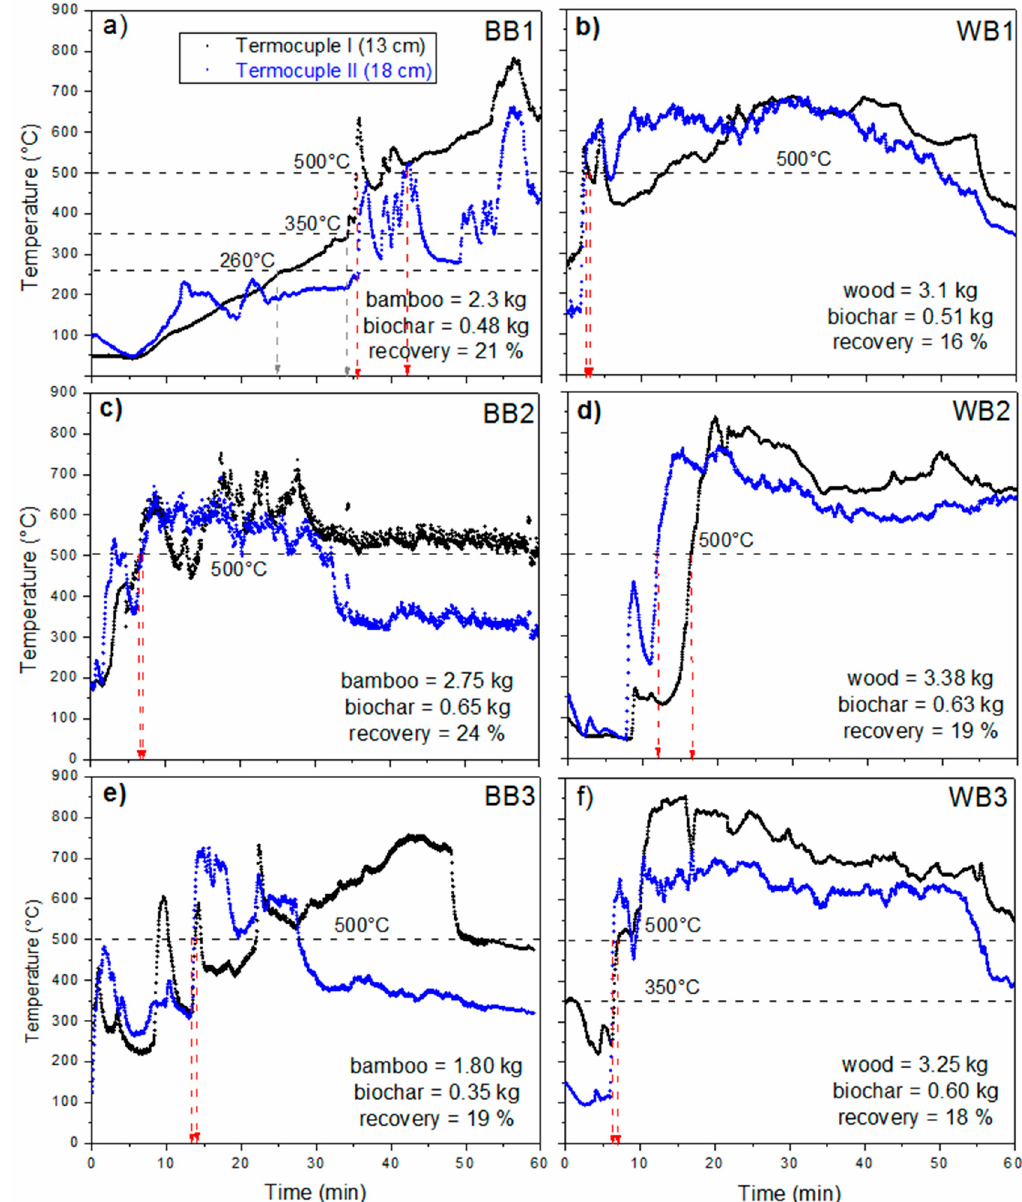
Figure 1. Pattern of temperatures of the triplicate charring lots during production of two biochars made of Guadua bamboo (BB), ( a ) BB1, ( c ) BB2 and ( e ) BB3, and pinewood waste (WB), ( b ) WB1, ( d ) WB2 and ( f ) WB3.